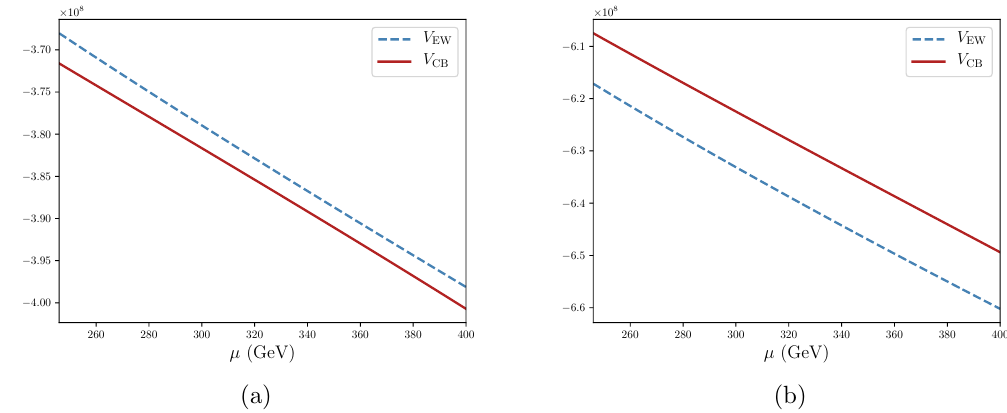
Figure 3. Same as in (cid:12)gure 2 but for the case where V